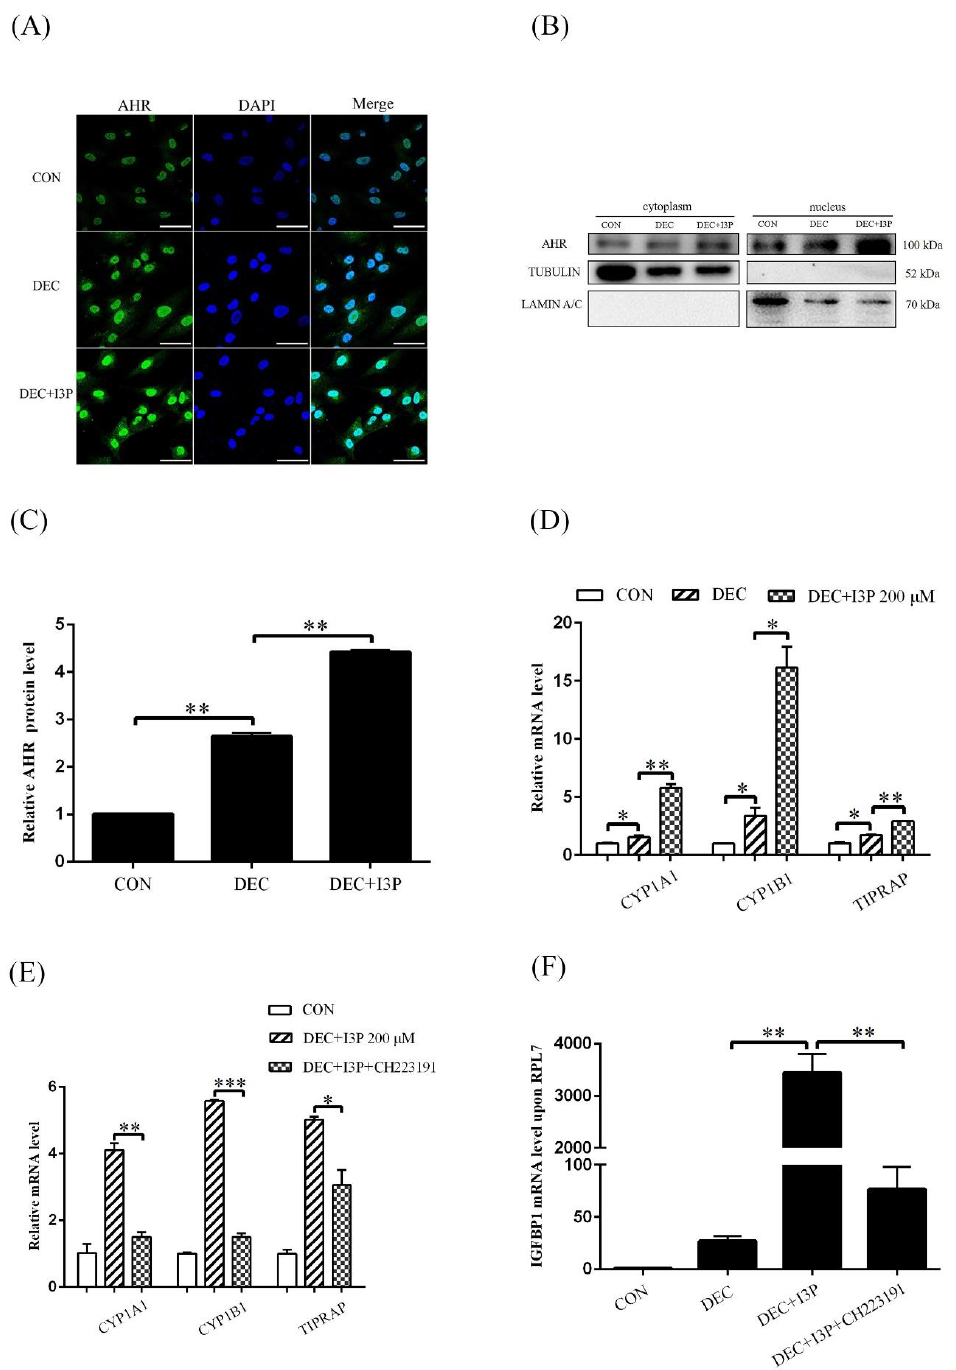
Figure 2. I3P stimulates human in vitro decidualization by activating AHR. ( A ) AHR immunofluorescence of decidual cells treated with 200 μM I3P under in vitro decidualization for 4 days. ( B , C ) Western blot analysis on AHR protein level in cytoplasmic and nuclear fractions after stromal cells were treated with I3P under in vitro decidualization for 4 days. ( D ) RT-qPCR analysis on the relative mRNA levels of CYP1A1 , CYP1B1 and TIPARP after stromal cells were treated with 200 μM I3P under in vitro decidualization. ( E ) RT-qPCR analysis on the mRNA levels of CYP1A1 , CYP1B1 and TIPARP after stromal cells were treated with I3P and CH223191. ( F ) The mRNA level of IGFBP1 after stromal cells were treated with I3P and CH223191. Scale bar = 50 µ m. CON, control. DEC, decidualization. *, p < 0.05; **, p < 0.01; ***, p <